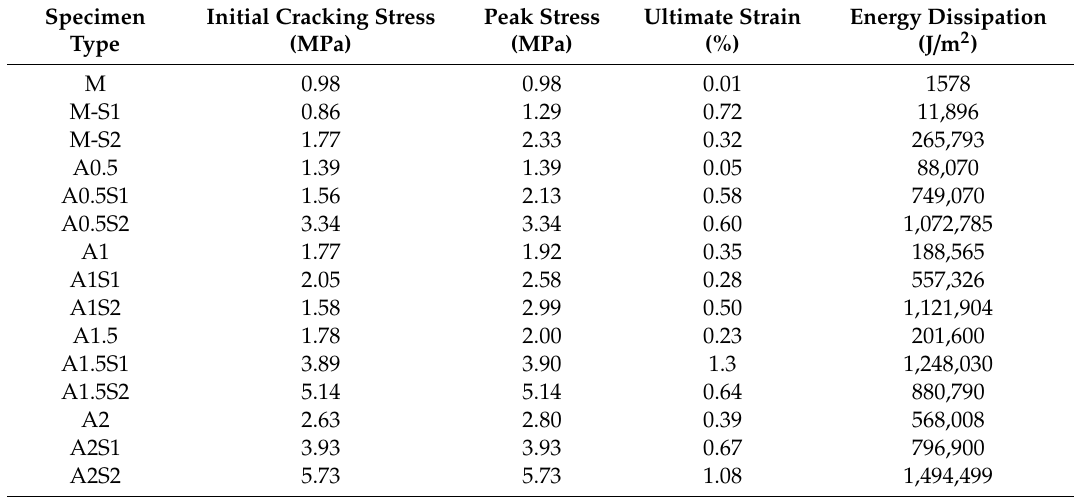
Table 6. Quasi-static tensile test results of the steel grid-PVA fiber reinforced